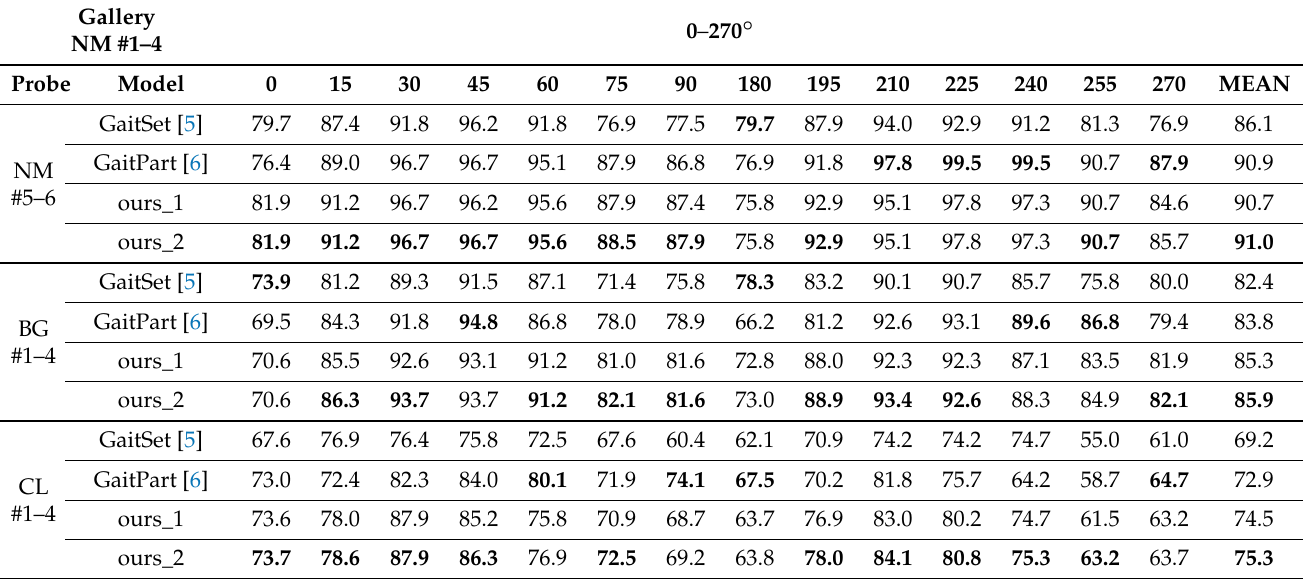
Table 4. Comparison results in the Multi-state Gait dataset, excluding identical-view cases. Here, our_1 does not include real personal physiological feature, and ours_2 includes gait silhouette features and real personal physiological features. The bolds indicate the best accuracy in this